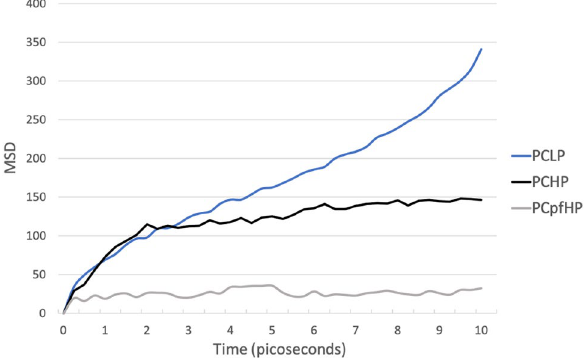
Fig. 16 Diffusion of Cl – ions through low-pressure Portland cement (PCLP) in blue, high-pressure Portland cement (PCHP) in grey, and Portland cement with particle hybrid glass and carbon fiber FCP material (PCpfHP) in black